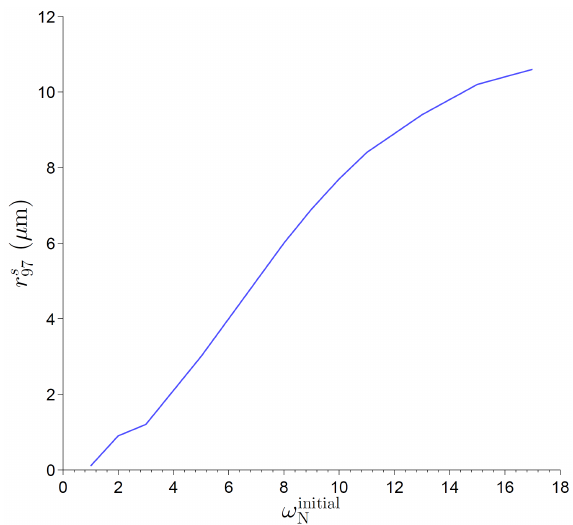
Figure 9. Influence of the overall Nitrogen content on the size of largest inclusions in the solid phase. (t s = 1000 s, oxide density = 10 11 m − 3